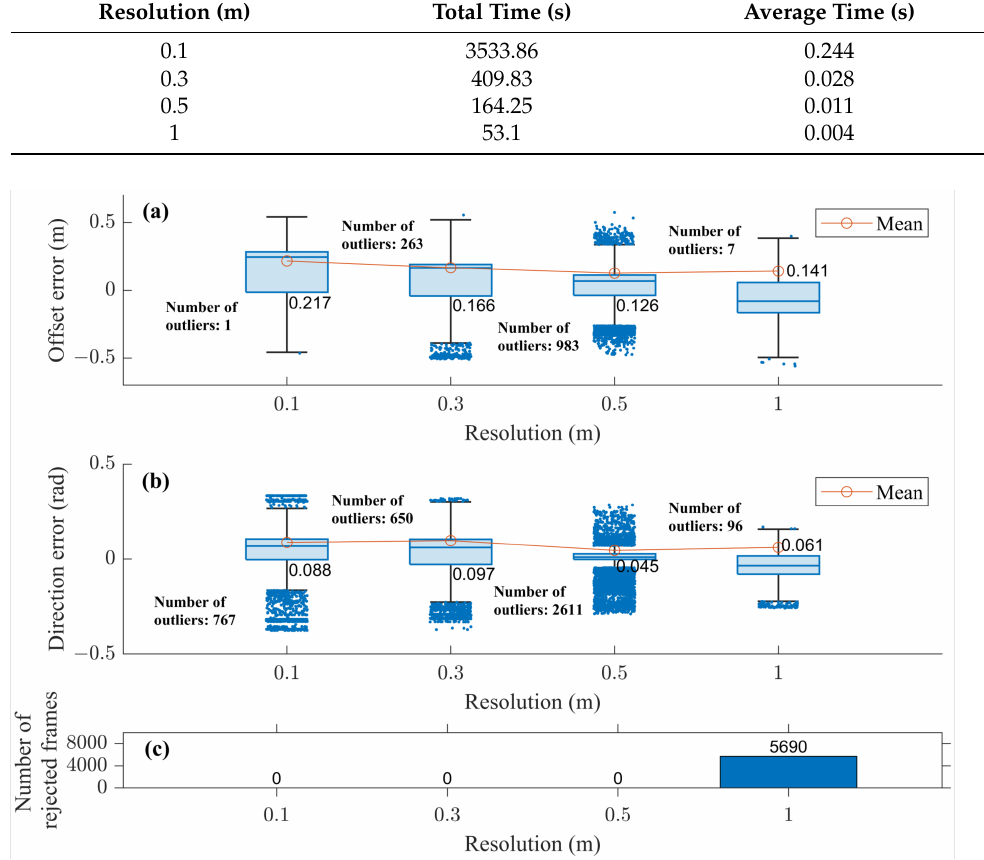
Figure 20. Error of proposed method for dataset 2 under different map resolutions: ( a ) offset error; ( b ) direction error; ( c ) number of rejected frames.